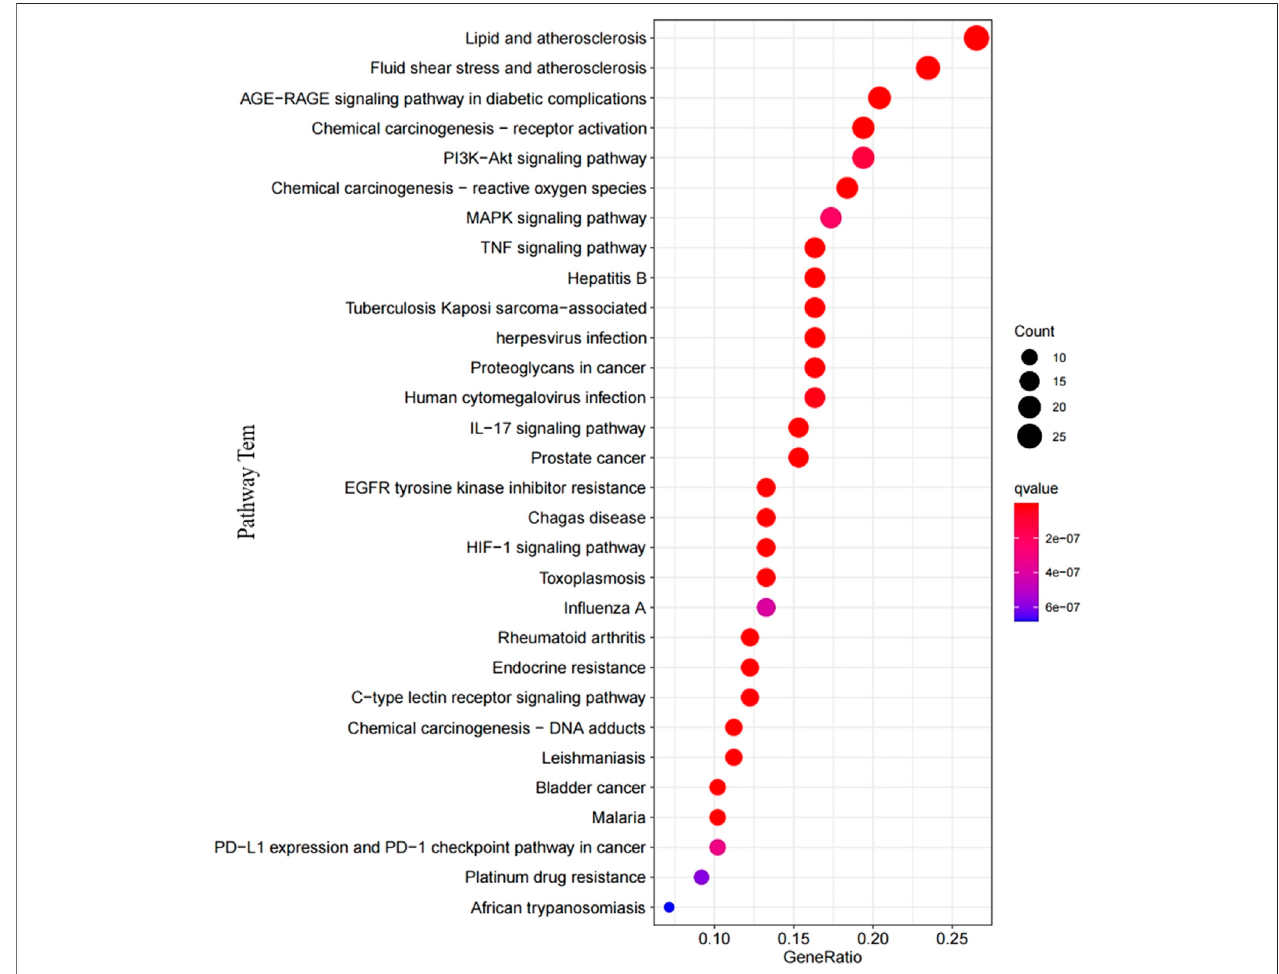
FIGURE 6 | The top 30 signi fi cantly enriched terms in KEGG